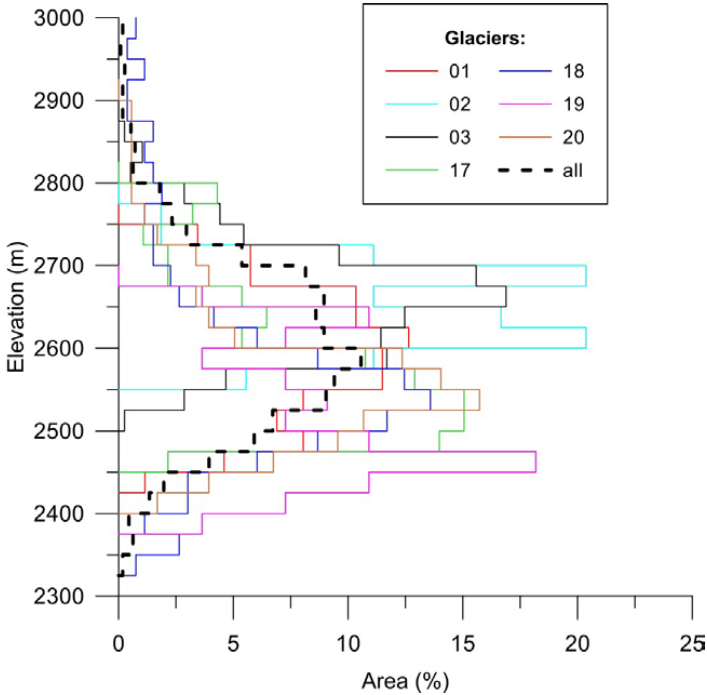
Figure 2. Area-elevation distribution for the studied glaciers in 2001. The area values were calculated for 25 m altitude intervals. for 25 m altitude